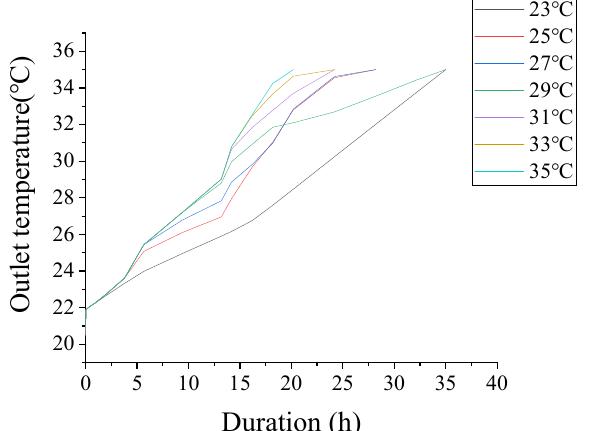
Figure 7. Influence of the phase change temperature on the outlet temperature of the reservoir.